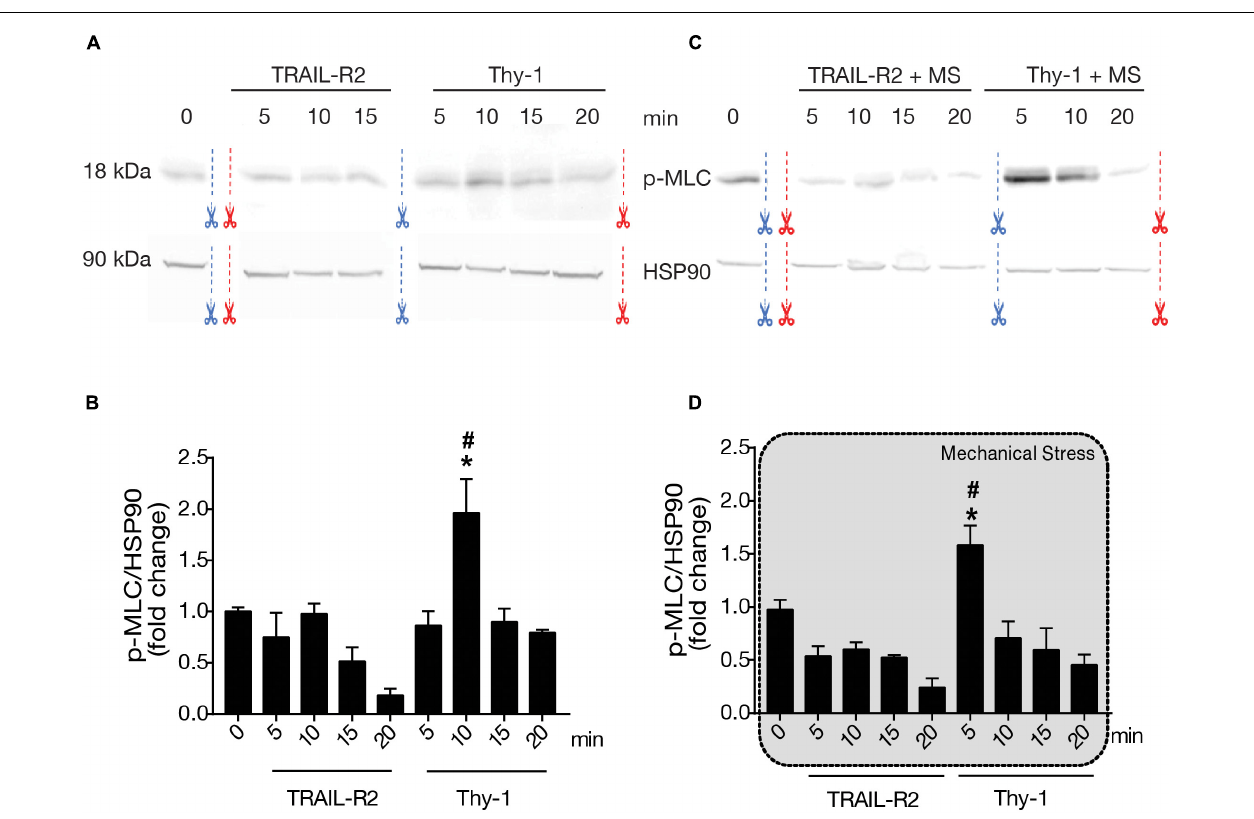
FIGURE 3 | Phosphorylation of Myosin Light Chain after Thy-1 stimulation, with or without mechanical stress. DITNC1 cells were incubated with serum-free medium for 30 min and stimulated as indicated in Figure 1 for 5, 10, 15, and 20 min. (A,C) Whole cell lysates were separated by SDS-PAGE and transferred to nitrocellulose for immunoblotting. Bands of 18 kDa correspond to Myosin Light Chain phospho-Serine 19 (p-MLC) and those at 90 kDa, to the Heat Shock Protein 90 (HSP90). Blue and red scissors indicate where the figure (immunoblot image) was cut so that bands match the order of sample appearance in the corresponding graphs. (B,D) Values in the graphs correspond to densitometric analysis of the p-MLC band intensity normalized to Heat Shock Protein 90 (HSP90) values. The application of mechanical forces exerted by a magnet are indicated using a gray shaded background in graph D. Statistical significance was calculated using Mann-Whitney non-parametric test. * and #, p < 0,05; *compared with the basal condition at T = 0, # compared with the value obtained at the same time with